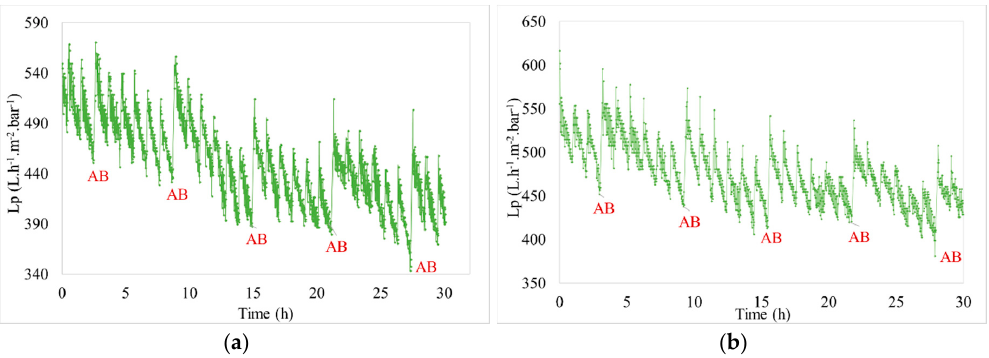
Figure 5. Variation of permeability vs. time (J = 60 L h − 1 m − 2 and t filtration = 60 min for Chronic pollution)—( a ) [oocytes] feed = 69 oo mL − 1 and ( b ) [spermatozoa] feed = 10,000 spz mL − 1 .